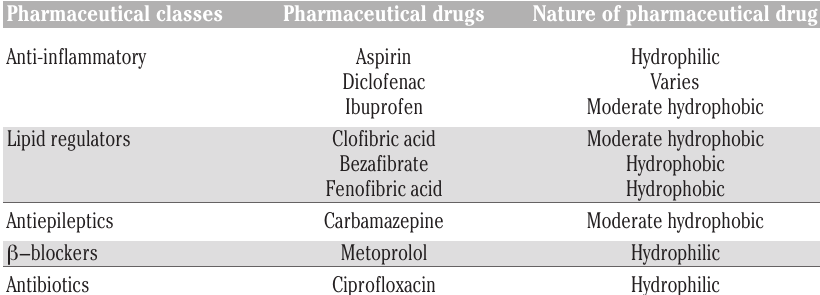
Table 1. Different classes and nature of pharmaceutical drugs.